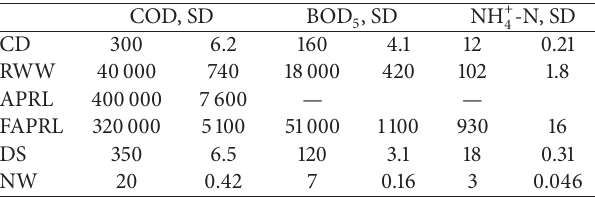
Table 1: Characteristics of different kinds of raw water (mg ⋅ L −1 ).